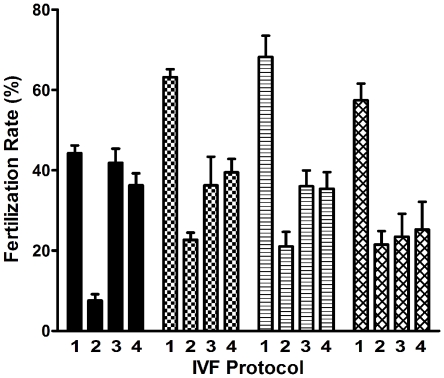
In vitro fertilization rates with cryopreserved C57BL/6J sperm in cell culture inserts and wells.The bar patterns, in groups of 4, indicate the volume of cryoprotectant used to extend the sperm prior to freezing. From L to R: 105 µL, 180 µL, 400 µL and 800 µL. Numbers within each group of 4 bars indicate IVF Protocol: Protocol 1, 6.5 mm insert; Protocol 2, 6.5 mm well; Protocol 3, 12 mm insert; Protocol 4, 12 mm well. Data are presented as mean ± SEM, n = 4. Significance of differences is described in text.